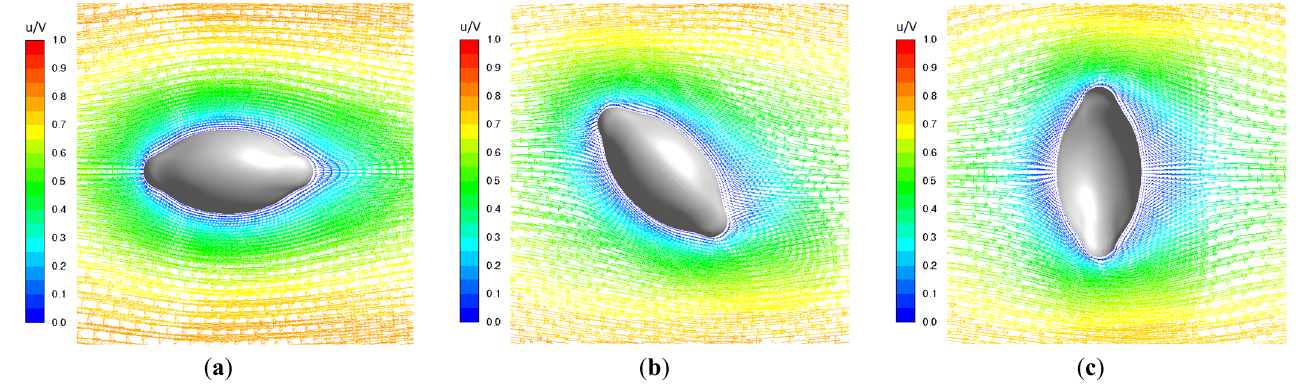
Figure 10. Velocity vector fields around TRI, for Re = 0.01, ( a ) θ = 0°, ( b ) θ = 45°, ( c ) θ = 90°.